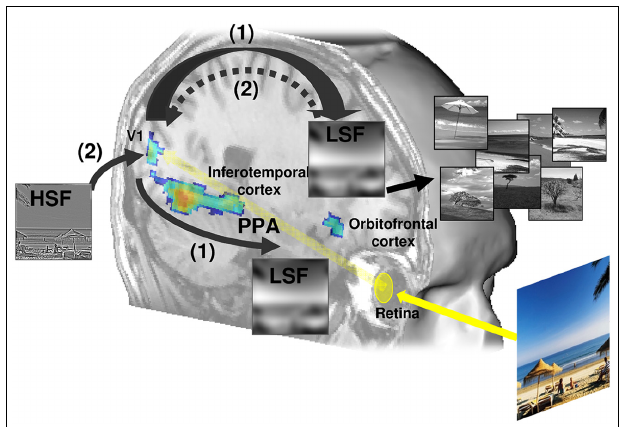
FIGURE 6 |A schematic illustration of the proposed coarse-to-fine cortical model. (1) Los spatial frequency (LSF) information reaches high-order areas of the dorsal visual stream rapidly, enabling coarse initial parsing of the visual scene (providing the spatial organization of the scene through the frontal eye fields and possible interpretations of the category of the scene through the orbitofrontal cortex), prior to its complete propagation along the ventral visual stream (inferotemporal cortex) that ultimately mediates the scene recognition. (2)This initial low-pass analysis might be then “retro-injected” through feedback into lower level areas (including the primary visual cortex,V1) to guide a slower analysis of high spatial frequency (HSF) information through the ventral visual stream and select the relevant finer details necessary for the recognition and identification. In this model, the coarse-to-fine analysis is preferentially performed in the right ventral visual stream, from the occipital to the inferior temporal cortex and the parahippocampal place area